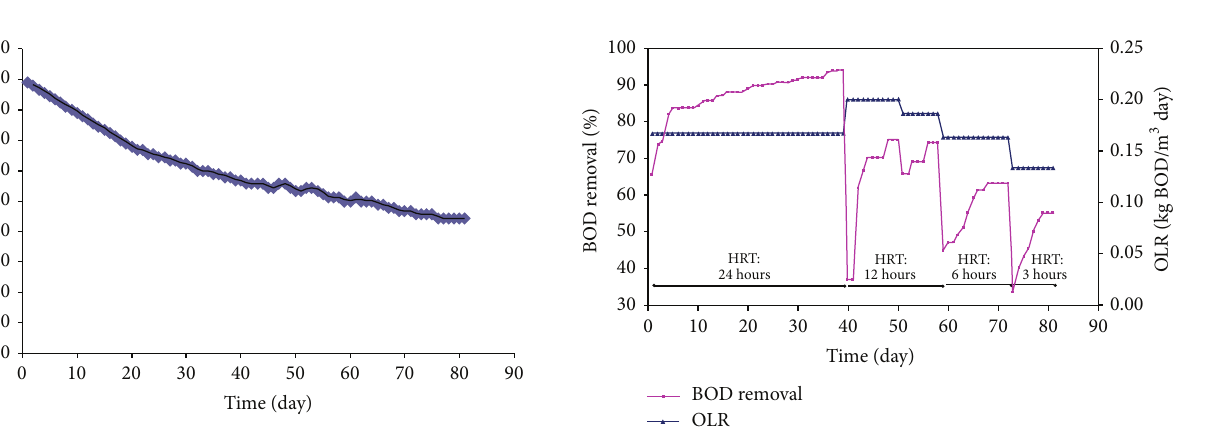
Figure 2: Flux variation obtained over time.